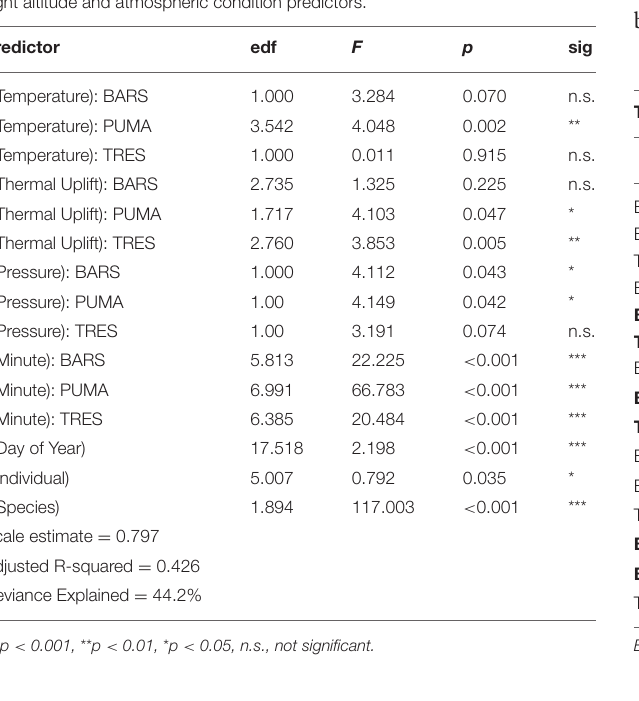
Frontiers in Ecology and Evolution |